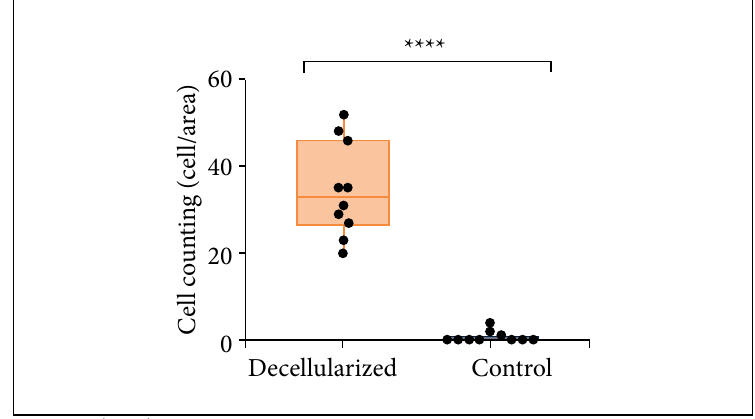
Figure 5 - Cell counting in a decellularized hydrogel graph. Control sample mean: 34,6 cells/area. Decellularized sample mean: 0,7 cell/area.